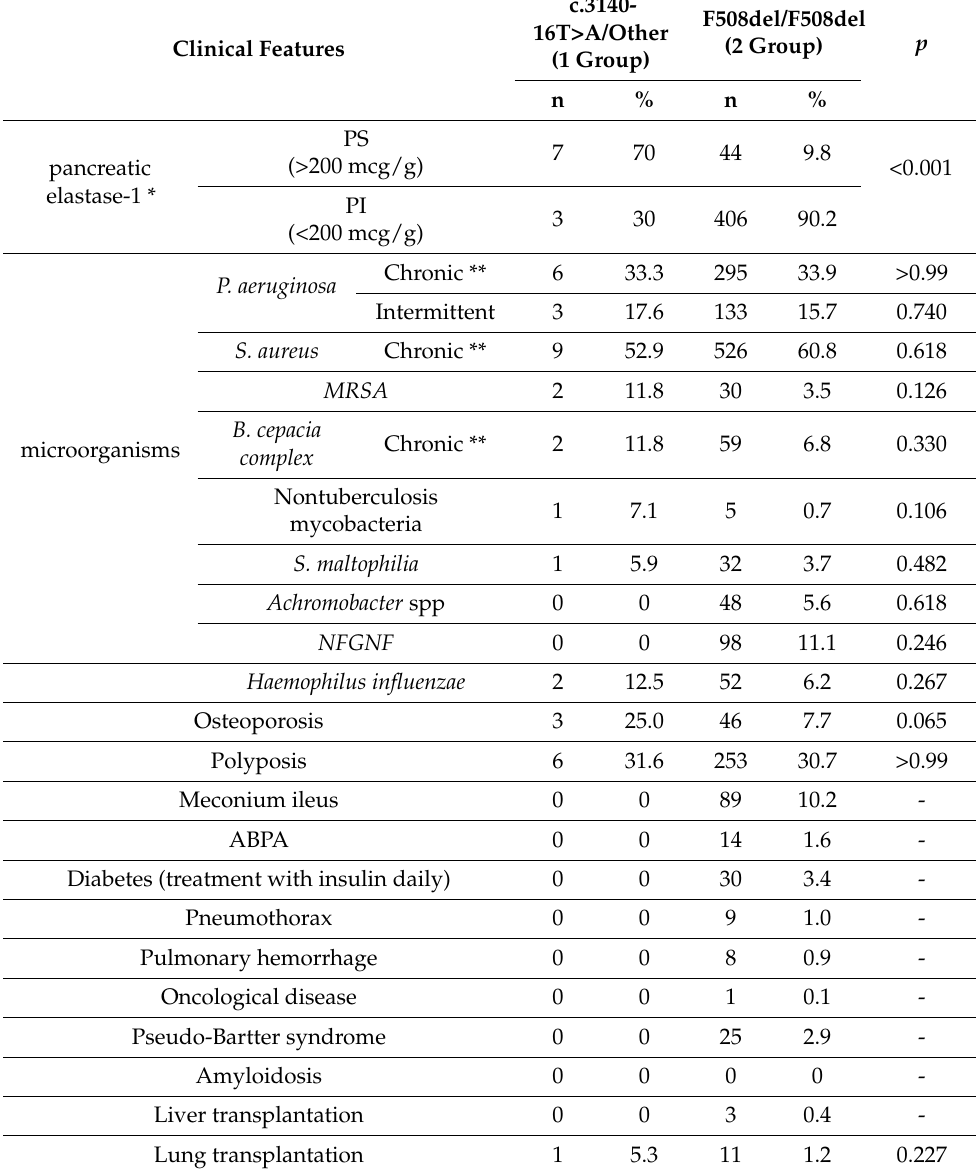
Table 4. Clinical characteristics of cystic fibrosis patients with different